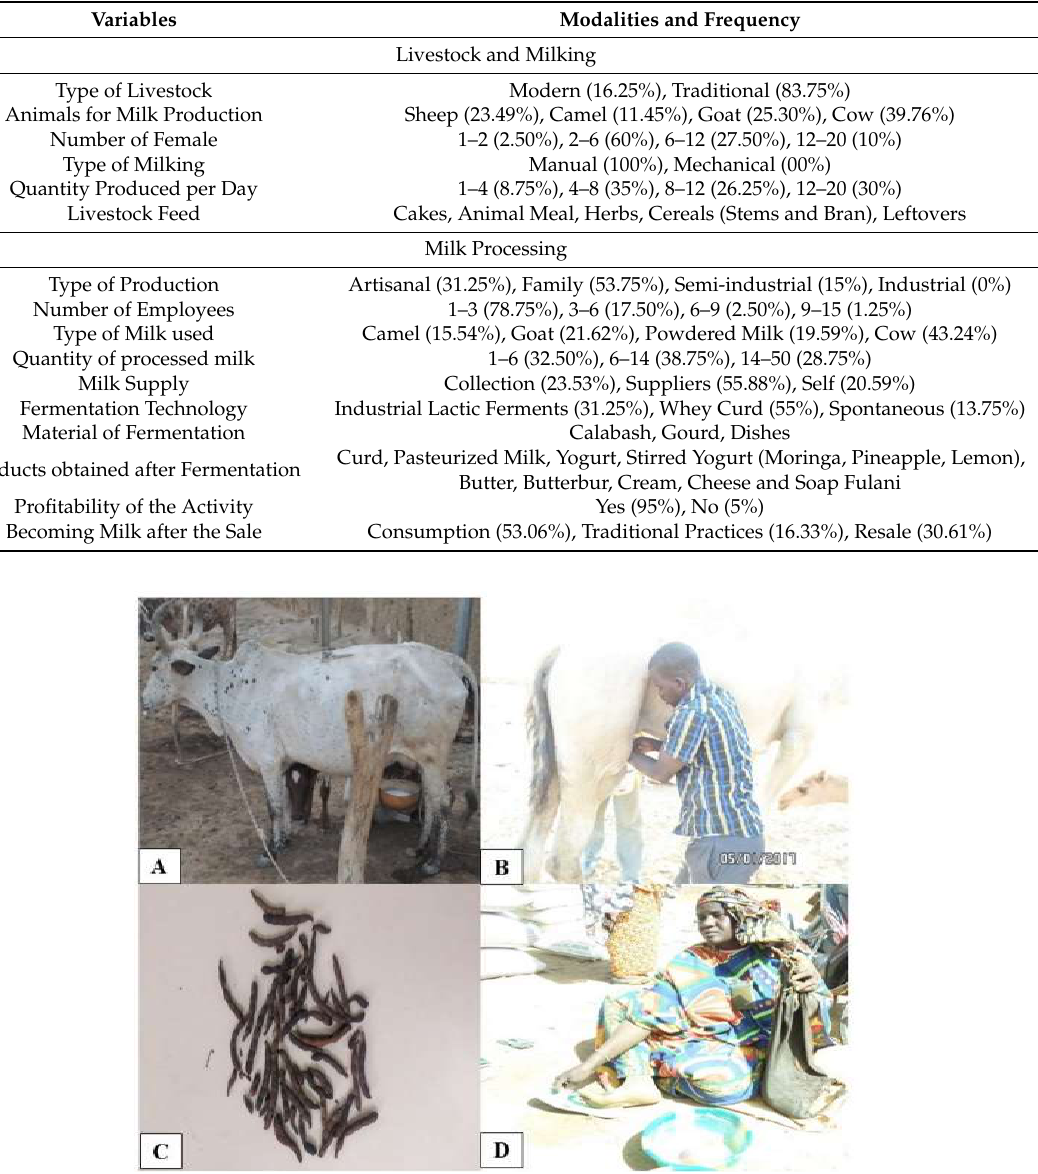
Figure 1. Milking Cow ( A ), Camel ( B ), Spice ( C ) and Leather Gourd containing Milk ( D ).